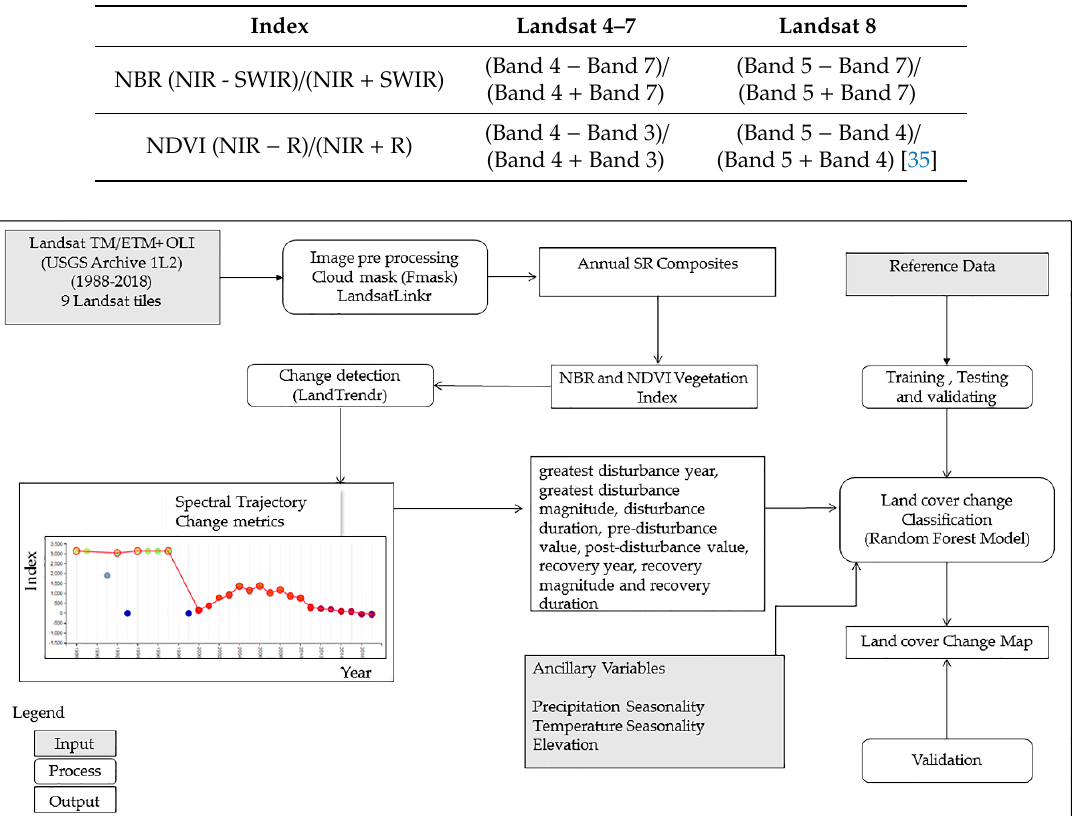
Figure 4. Diagram illustrating the workflow implemented in this study.